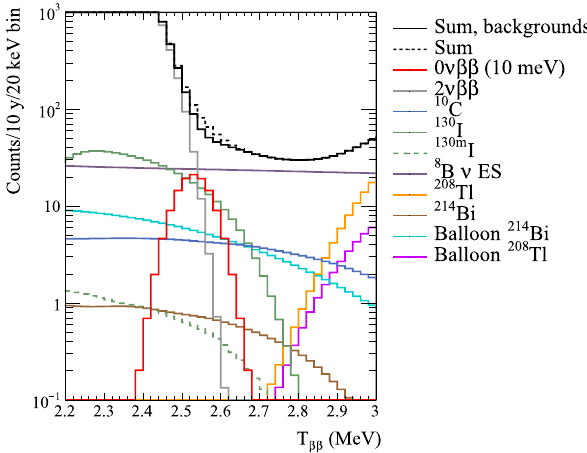
backgrounds, and 50% for the 8 B solar neutrinos. (Left panel) 5% nat Te loading and (Right panel) 3% enr Xe loading